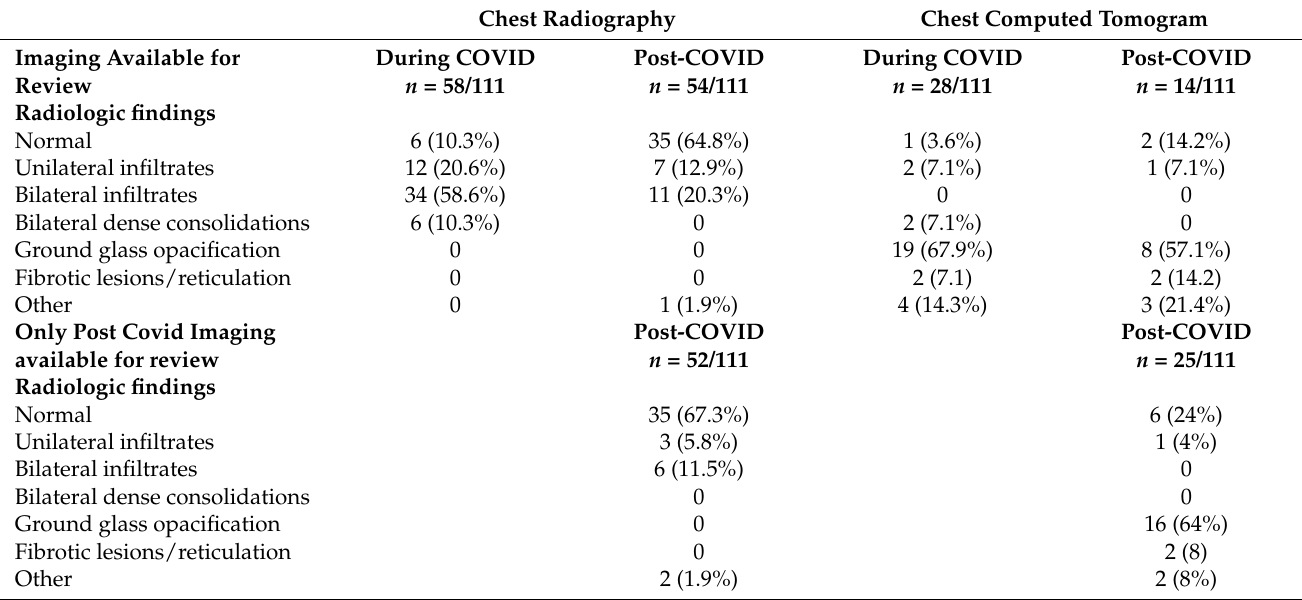
Table 4. Chest imaging findings in the 111 patients. Chest Radiography Chest Computed